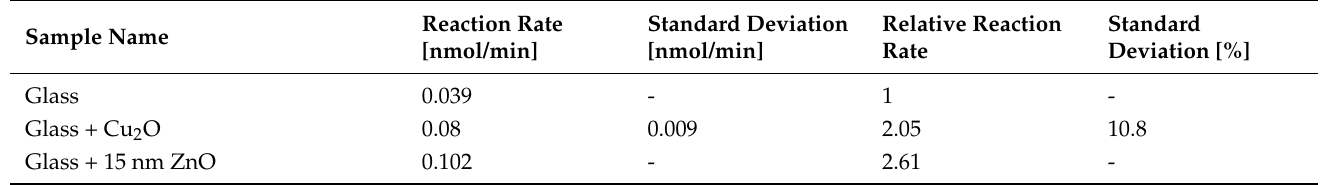
Table 1. Reaction rates and relative reaction rates (with bare glass as unity) of the samples tested. Except for the comparison samples with simple structure (glass and glass + 15 nm ZnO, for these values are taken from [38]), averages for three independent photodecomposition experiments are shown. Note that a large volume of RhB solution (20 cm 3 ) was used with a circular photocatalytic surface of 8 mm in